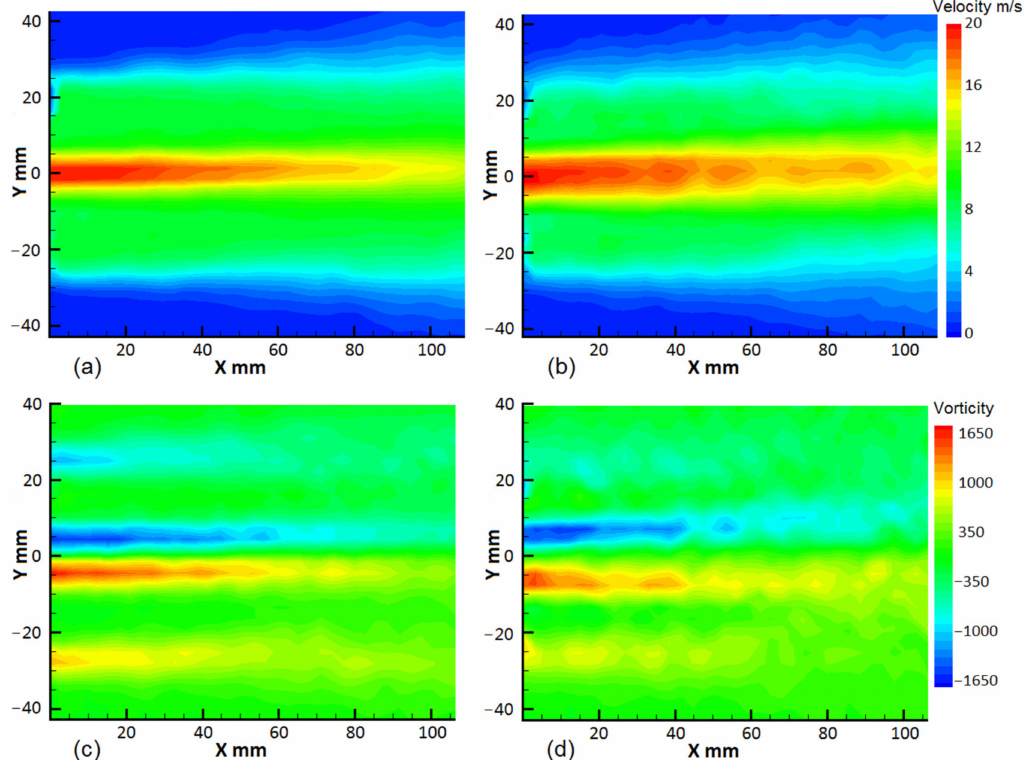
Figure 2. Time average velocity ( a , b ) and vorticity ( c , d ) distribution of nozzle A without ( a , c ) and with ( b , d )